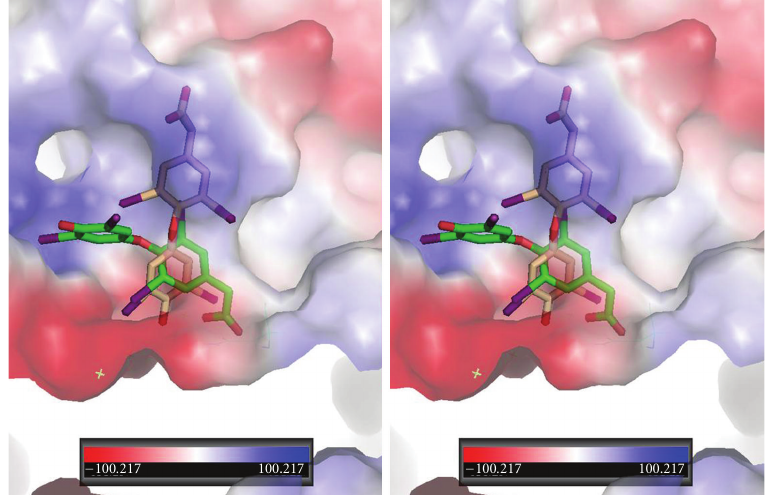
Figure 7: Stereoview of QM/MM model for T 4 ac bound in α v β 3 integrin at the RGD binding site. T 4 ac bound in two orientations: one orientation (green, Ca1) has the phenolic ring binding in a di ff erent pocket than that of T 4 while the other orientation of T 3 (beige, Ca2) binds in a mode that is perpendicular to the